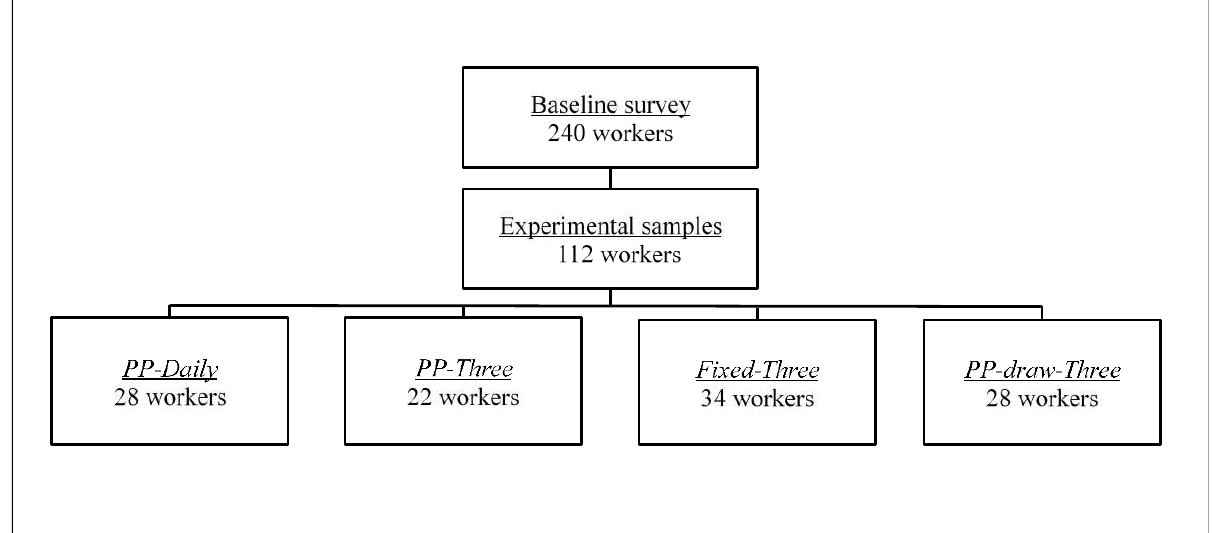
Fig. 1. Experimental design and sample